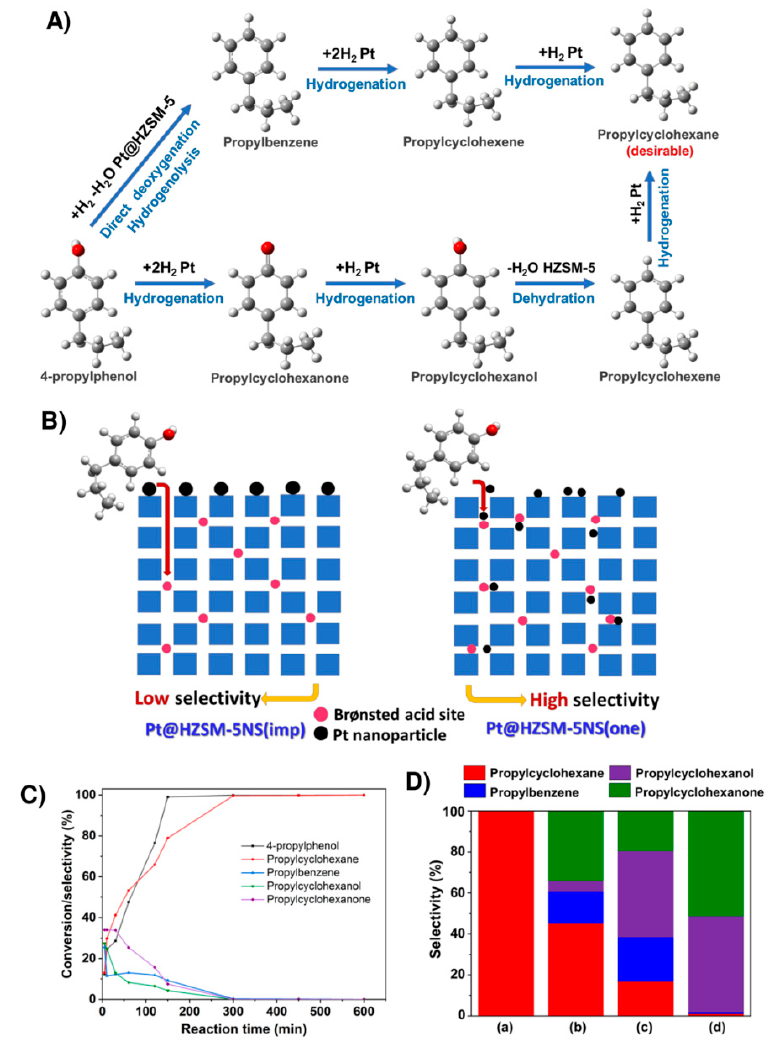
Figure 3. ( A ) Proposed reaction pathway of the 4-propylphenol conversion to propylcyclohexane over bifunctional Pt supported on an acid catalyst, ( B ) Illustration of the proposed perspective of 4-propylphenol conversion over Brønsted acid sites and Pt active sites of Pt/HZSM-5NS(imp) and